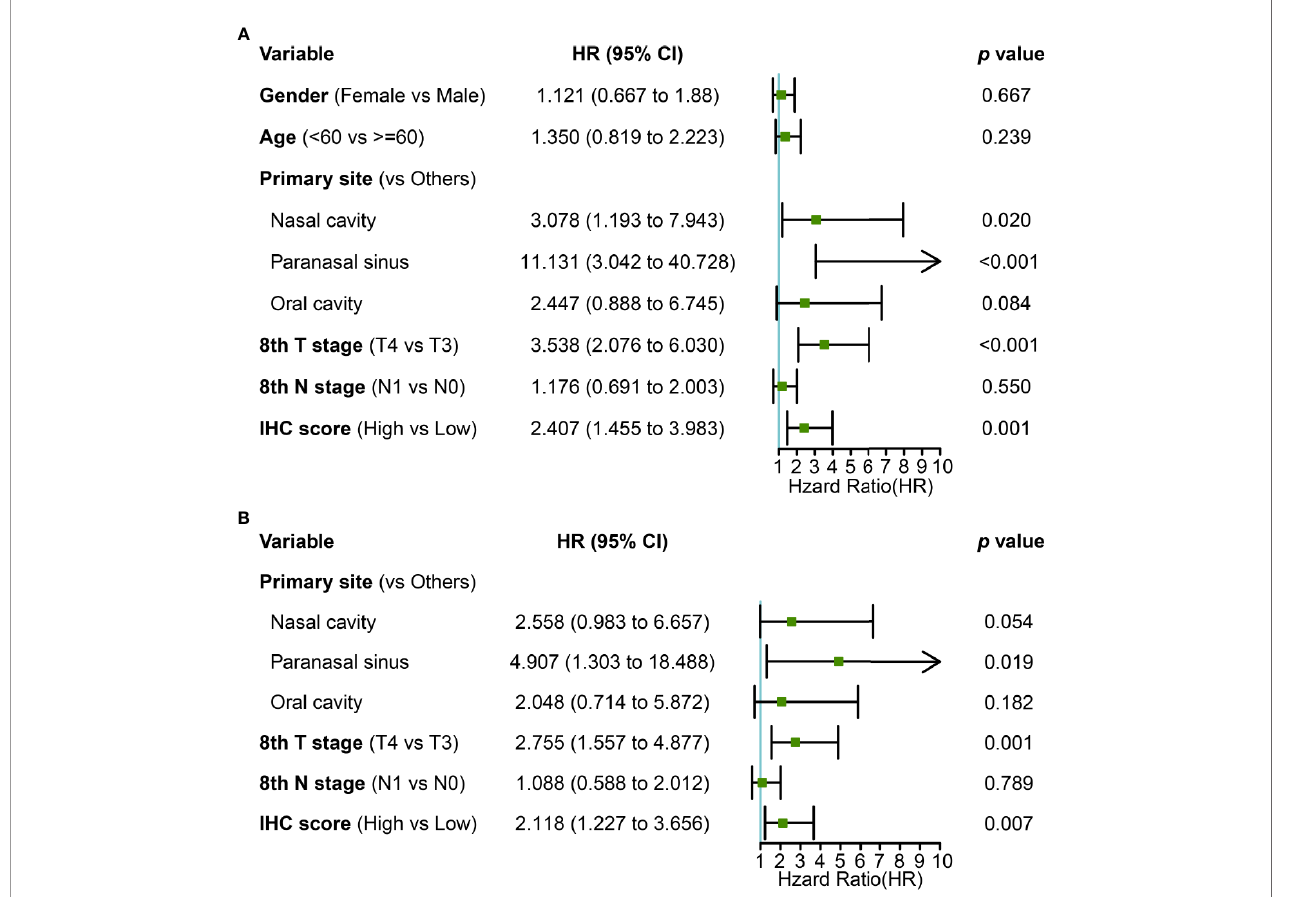
FIGURE 4 | (A) univariate and (B) multivariate Cox regression with clinical information and IHC score for OS.